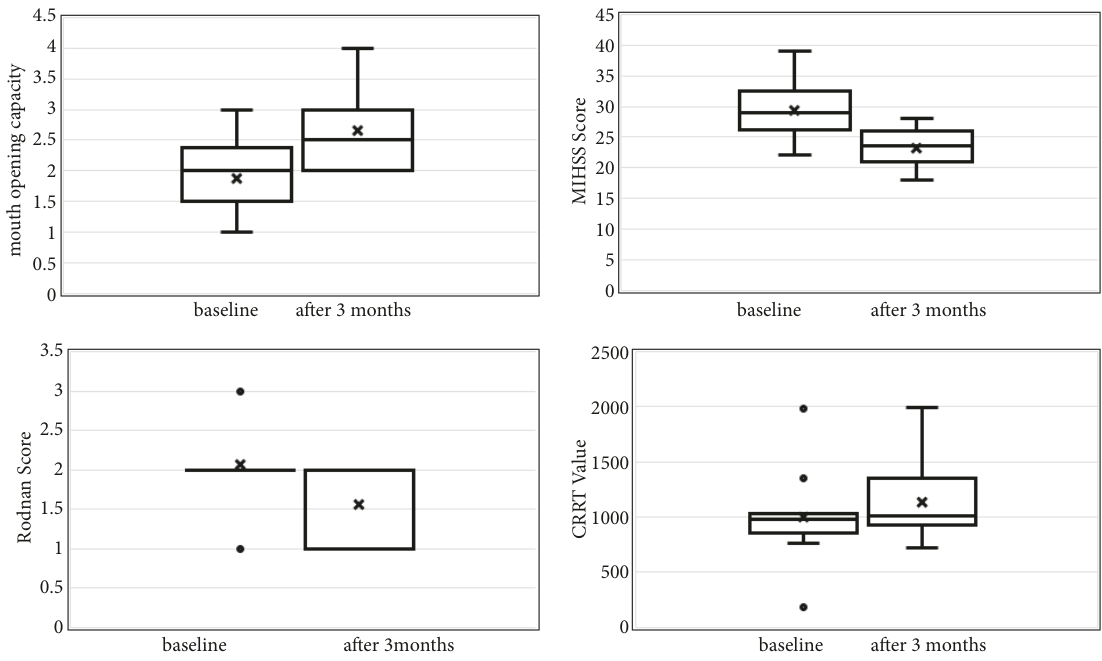
Figure 1: Pre- and postoperative changes of several parameters related to oral opening, mouth handicap in systemic sclerosis (MIHSS), sclerosis (Rodnan score), and cutaneous resonance running time (CRRT).